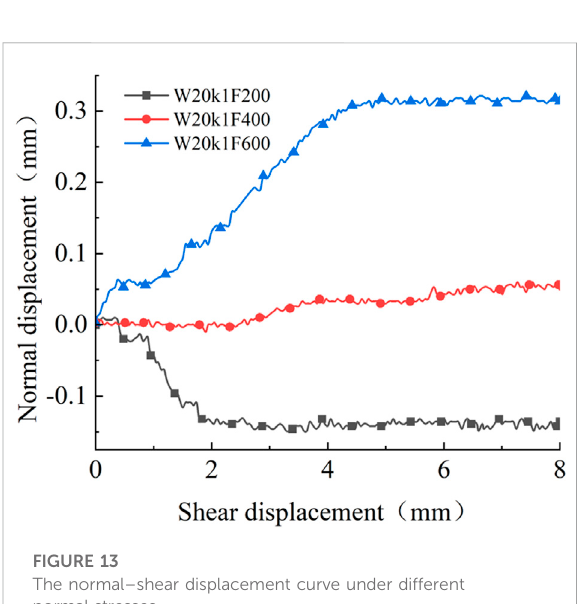
FIGURE 13 The normal – shear displacement curve under different normal